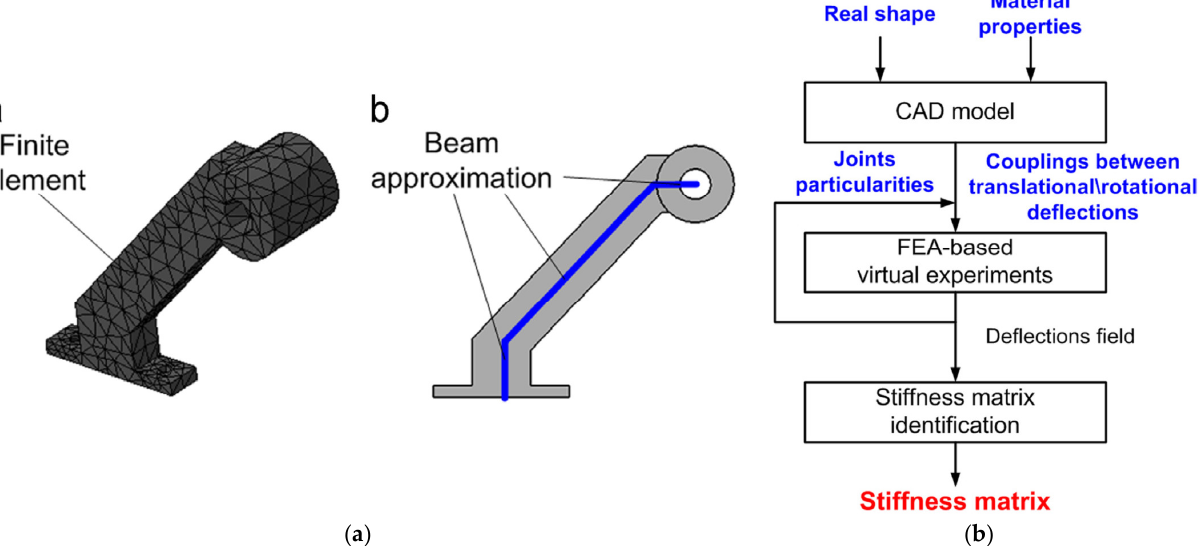
Figure 3. Stiffness identification with FEA [59]: ( a ) CAD model of a link with a complex shape and ( b ) algorithm for the stiffness matrix identification procedure.